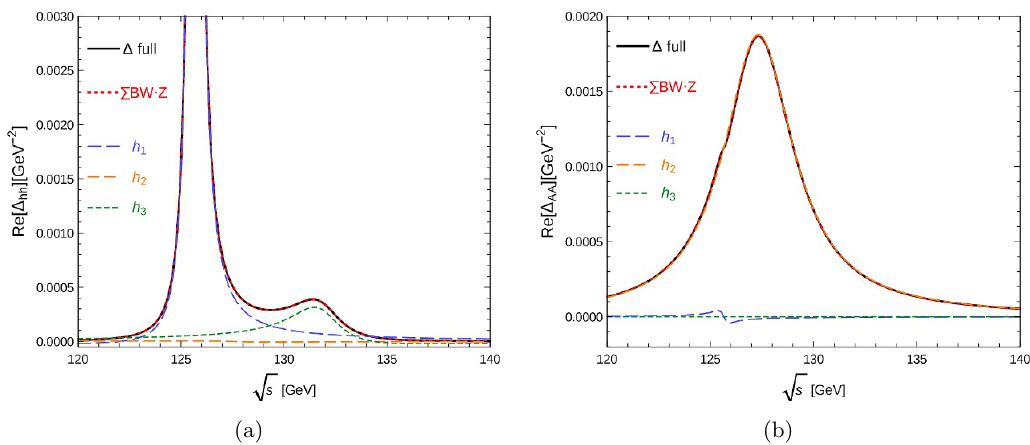
Figure 7 . Diagonal propagators (cid:1) hh ( p 2 ) ( (a) ) and (cid:1) AA ( p 2 ) ( (b) ) depending on the real momentum p p 2 = s around s ’ M h ; M h ; M h . Labelling as in (cid:12)gure 1 2 3